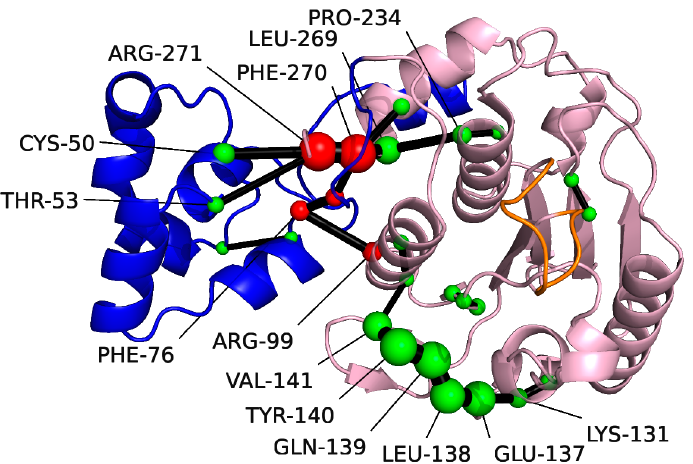
Figure 4. Amino acids identified with the Shortest Path Map (SPM) for pS273R using Sphere. The Arm structural domain colored in blue, the core structural domain in pink, and THR159-LYS167 in orange. The size of the sphere indicates the importance of the location, and the black edge indicates the communication pathway (how the different residues are connected). Residues at the communication interface between the Arm region and the core structural domain colored in red.